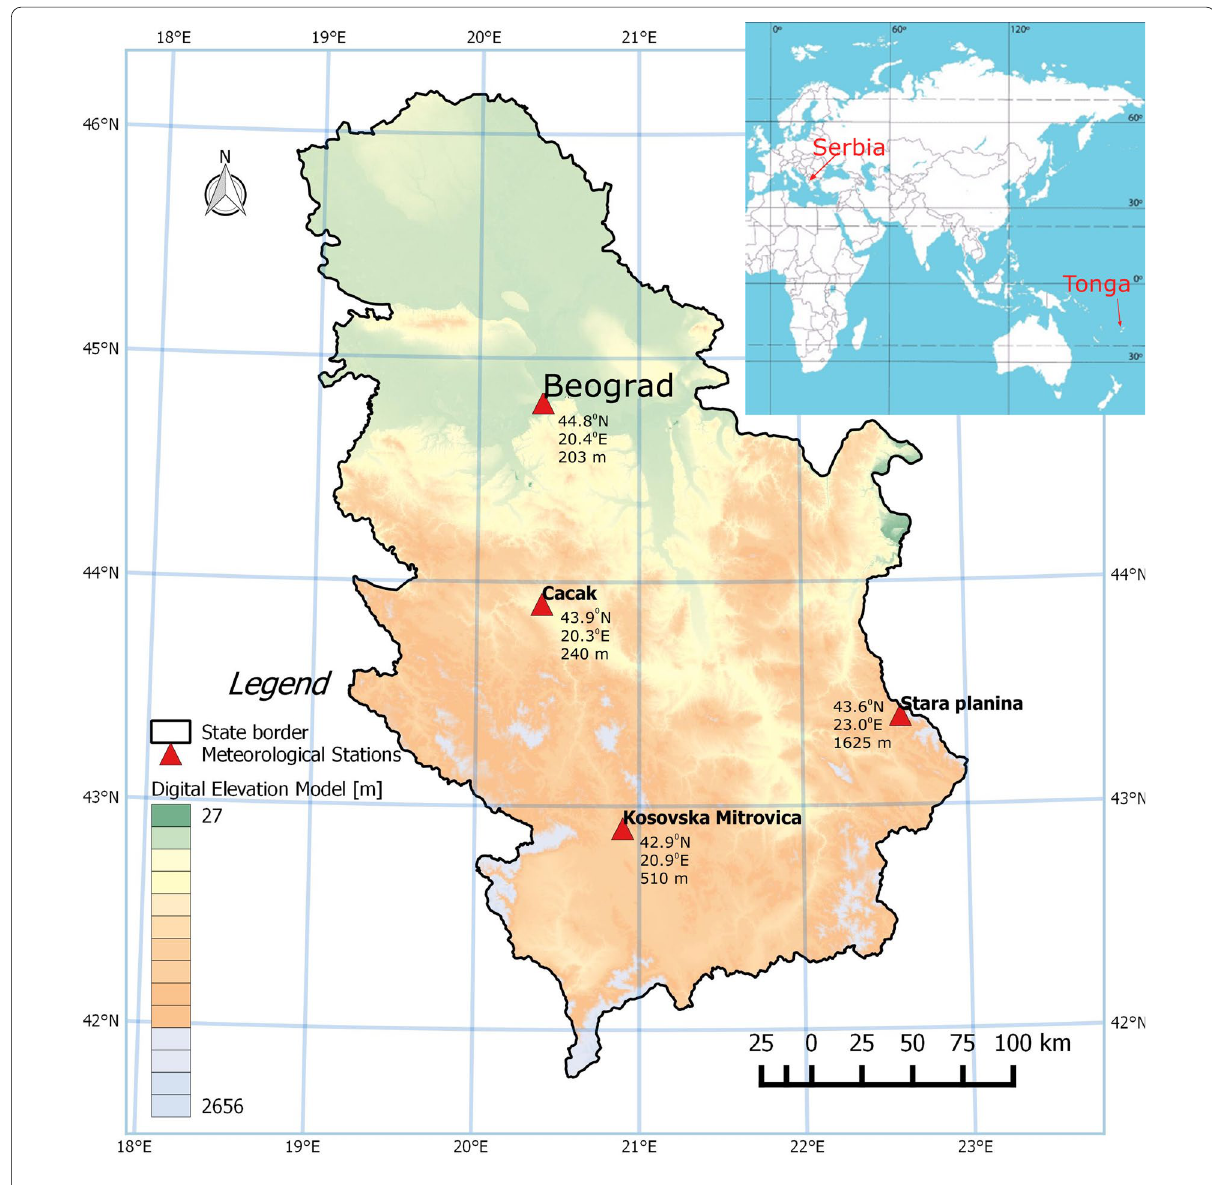
Fig. 1 Geographical position of meteorological stations in Serbia included in the analysis